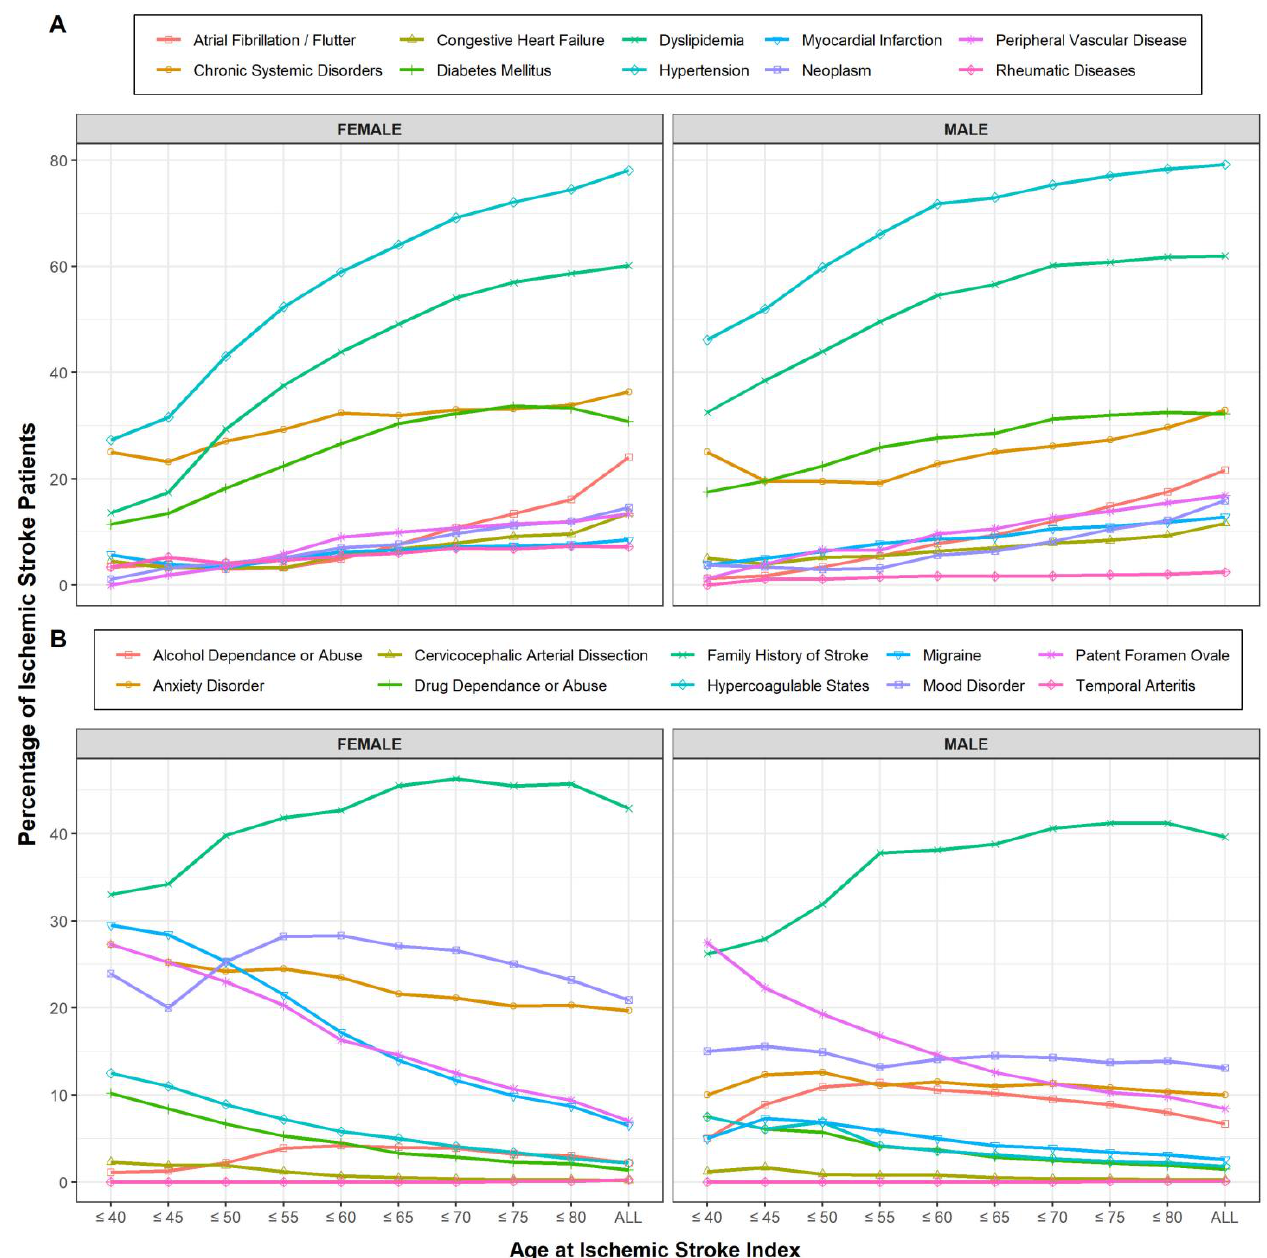
Figure 1. Line graph showing the prevalence of comorbidities as a percentage of the group total (y- axis) with respect to the age bracket increments (x-axis). ( A ) Line graph of first half of risk factors, ( B ) Lines graph of the second half of risk factors. All risk factors are spread over two graphs for clarity given high number of risk factors.